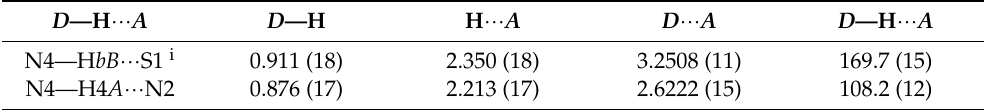
Table 5. Hydrogen-bond geometry (Å, ◦ ) for compound 3 .